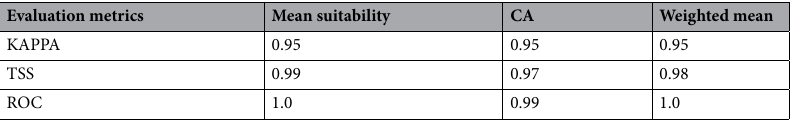
Table 2. The ensemble model performance by Kappa, TSS, and ROC evaluation metrics. CA, committee